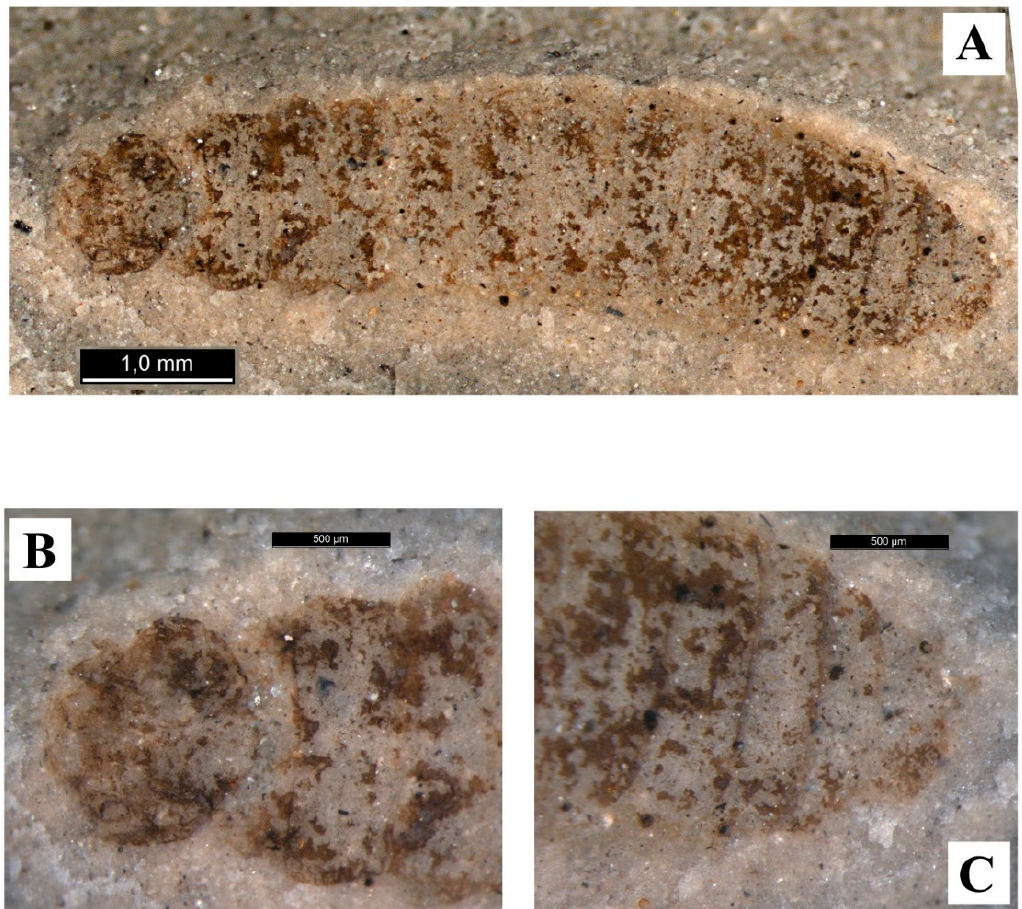
Figure 3. Tshekardocoleidae. Gen. et sp., larva, PIN 1700 / 4747, counterpart (Permian: Cisuralian, Artinskian-Kungurian; Perm’ Region, Tshekarda): A —body wettened by alcohol, B —head, dry, C —abdominal apex, dry; scale for each picture; original.